Question: What style of plot is this figure drawn as?
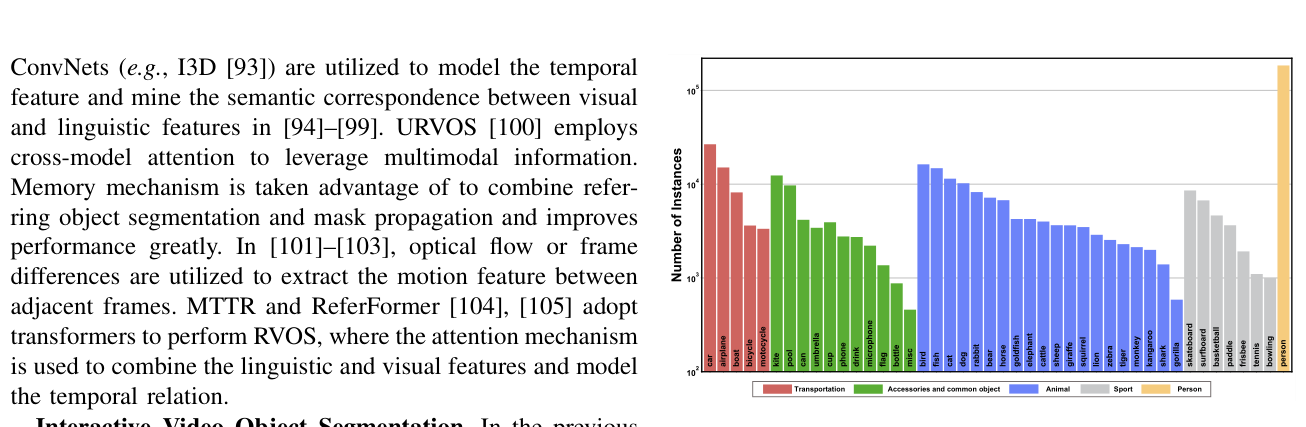
Answer: histogram